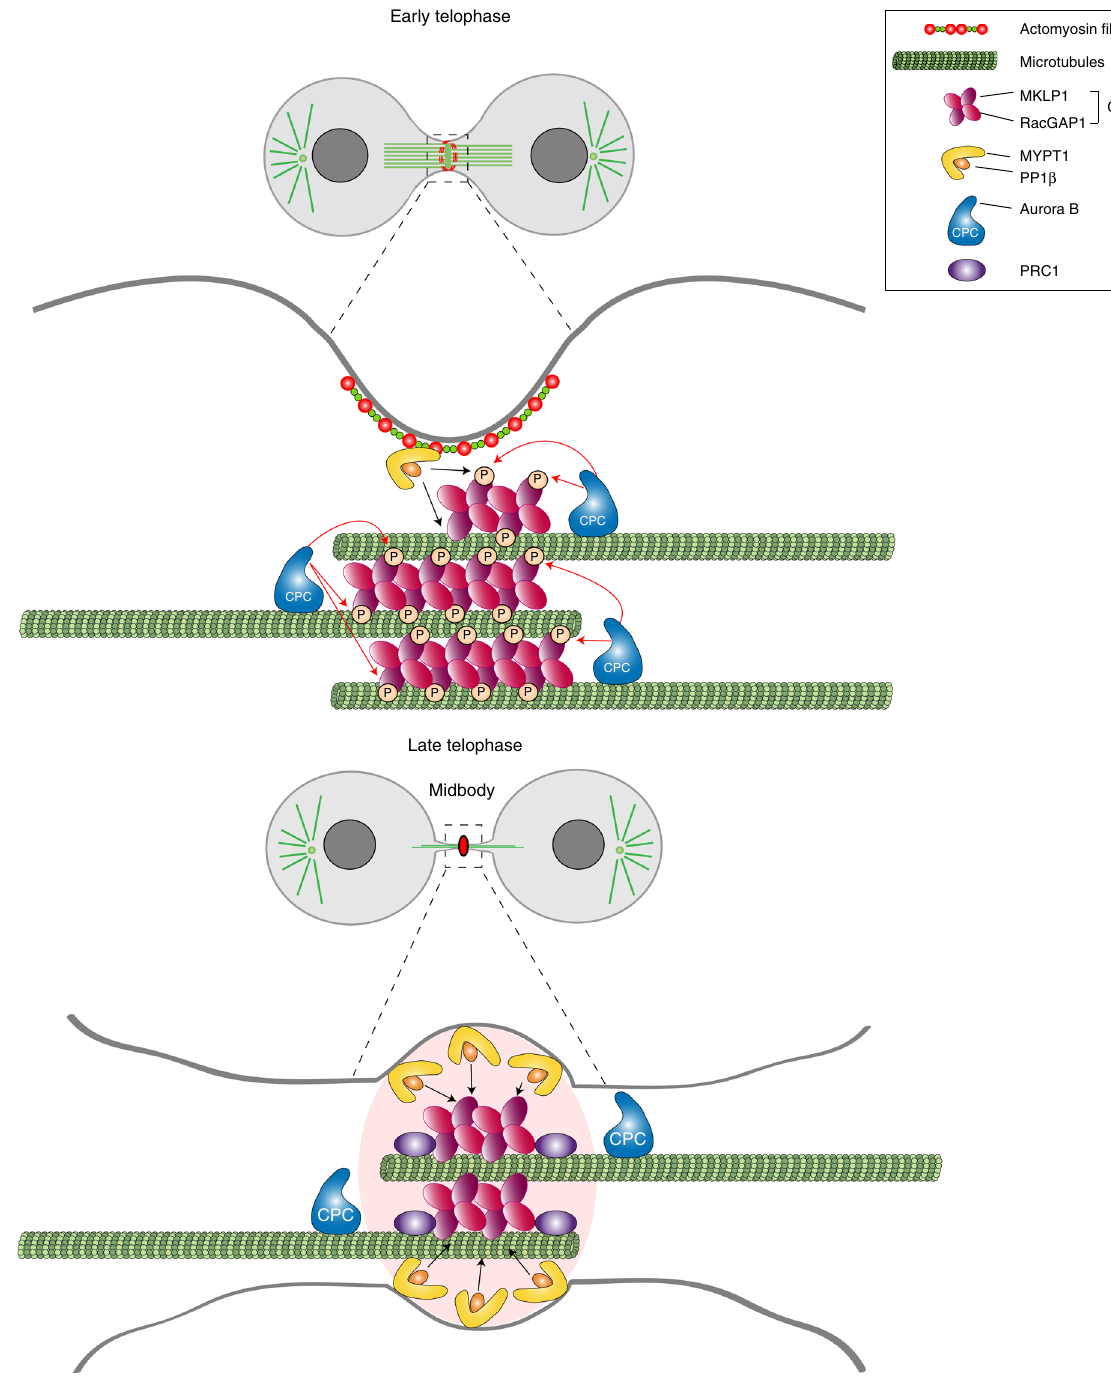
Fig. 8 Model of regulation of centralspindlin by Aurora B and MYPT1-PP1 β during cytokinesis. During furrowing (top panel) MYPT1-PP1 β accumulates at the cortex with no or very limited access to the centralspindlin pool that localizes to the central spindle midzone, which is highly phosphorylated by Aurora B and therefore can form clusters. After completion of furrow ingression, MYPT1/PP1 β accumulates at the midbody ring whereas Aurora B localizes to the midbody arms (bottom panel). This allows PP1 β to de-phosphorylate MKLP1 at S708, which could strengthen the association of centralspindlin with PRC1. See text